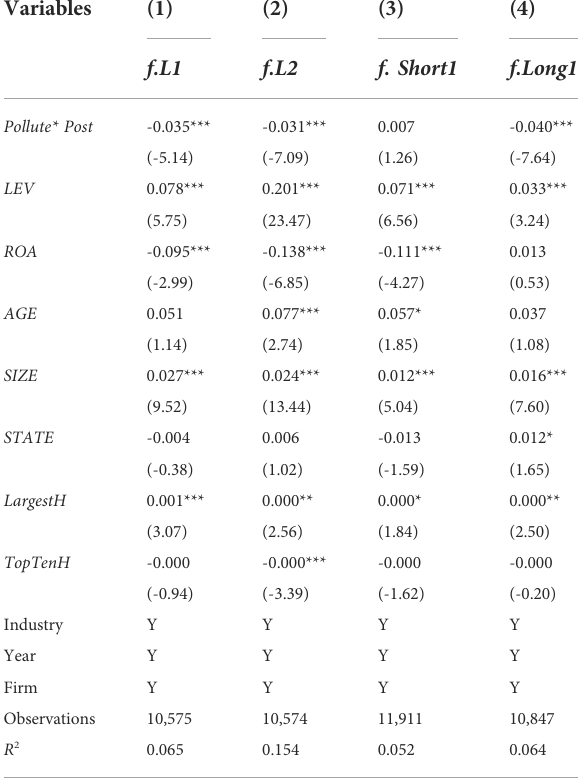
TABLE 11 T+1 Period of Green Credit Policy on Corporate Debt Financing.